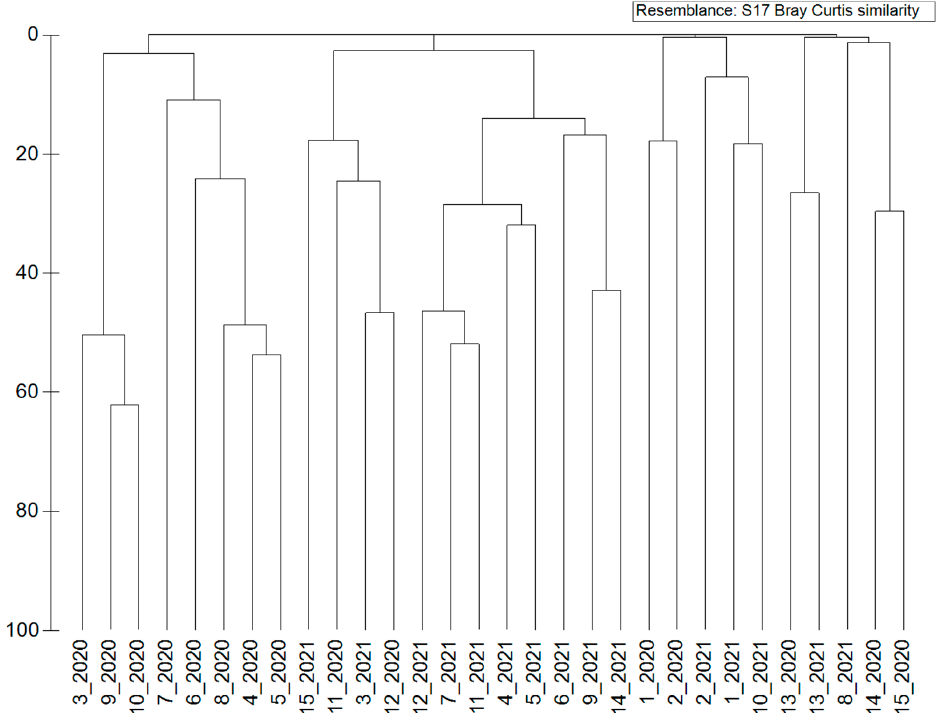
Figure 7. Cluster analysis of the similarity in the taxonomic composition between the studied sites in 2020 and 2021.